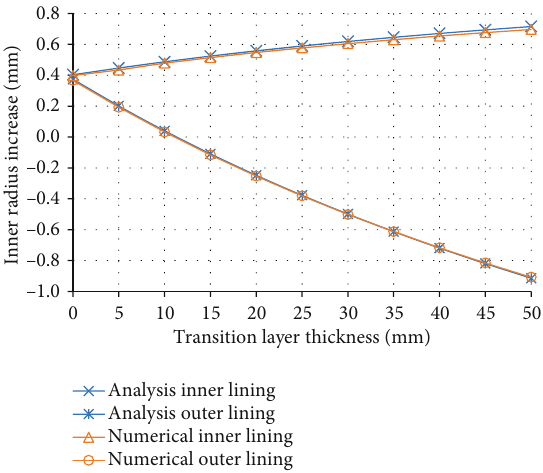
Figure 9: Increase of inner radius of inner and outer linings with di ff erent thickness of transition layer.